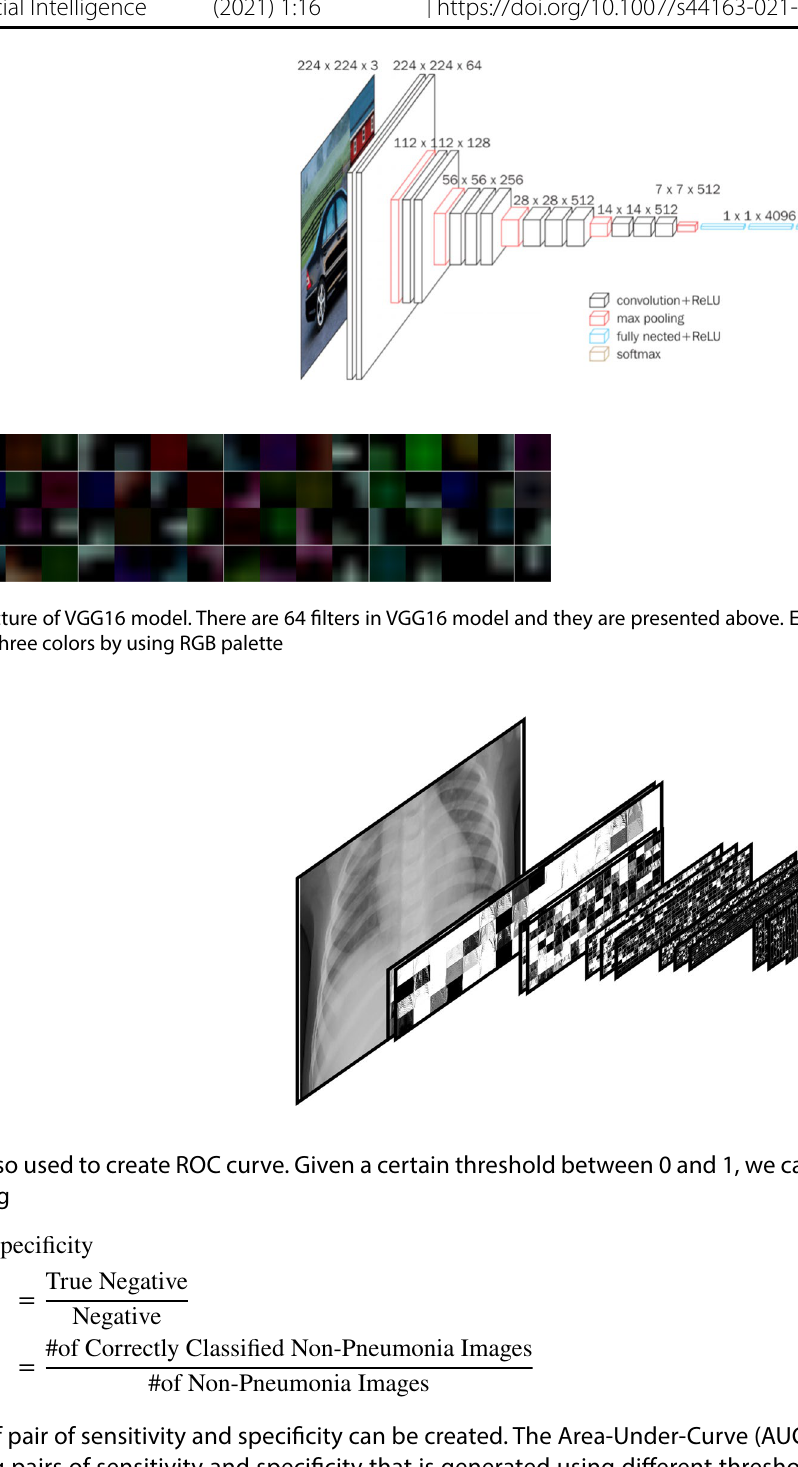
Fig. 7 The VGG16 Architec- ture Simonyan and Zisserman